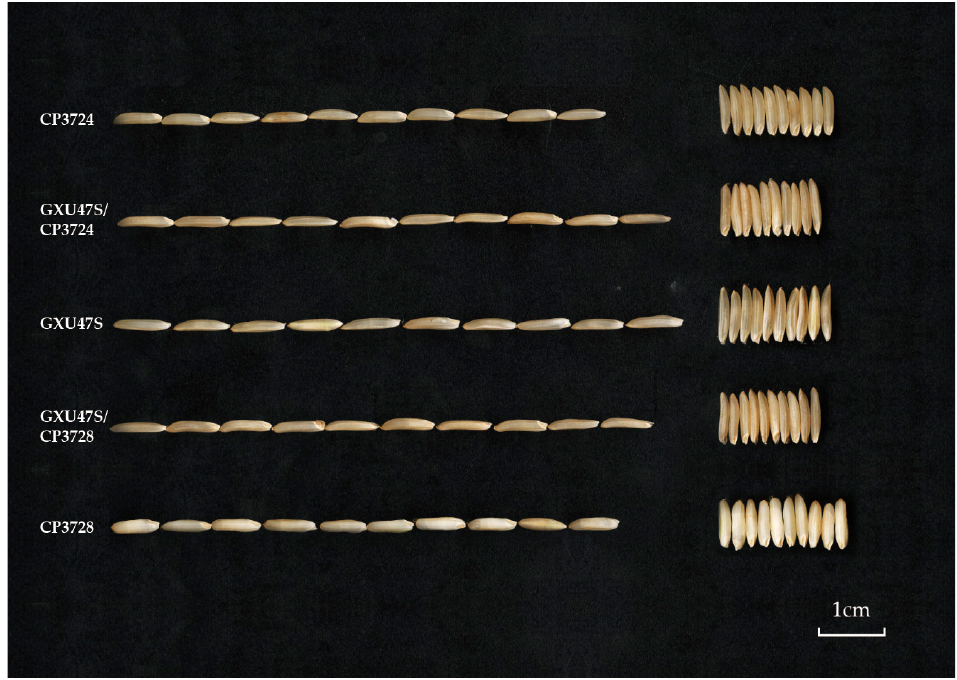
Figure 5. Grain phenotype of GXU47S/CP3724, GXU47S/CP3728, and their parents. Table 3. Quality traits of hybrids and their